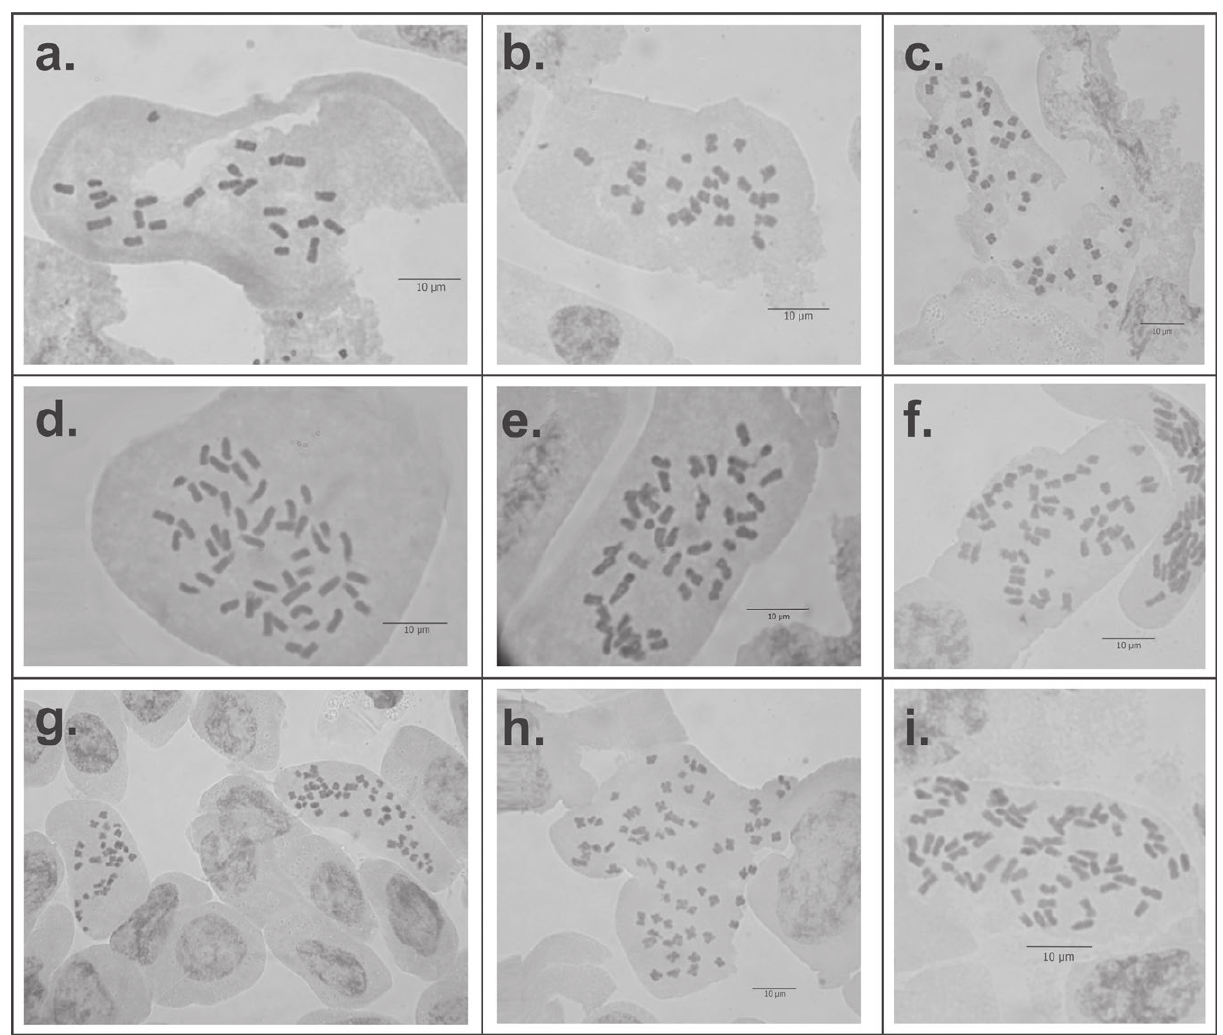
Figure 1. Karyotypes representative of P. peruviana genotypes. a. and b. n = 2x = 24 genotypes 12U398 and 09U292-7. c. 49 chromosomes genotypes 09U261-2. d., e., and f. 2n = 4x = 48 genotypes 09U134-3, 09U048-1 y 09U120-3. g., h. and i. mixoploids 38, 48 y 71 chromo- somes, genotypes 09U136-3, 09U296-2 and 14U422. Scale of 10µm. All the photos were taken at 100X except for image 1h, which was taken at